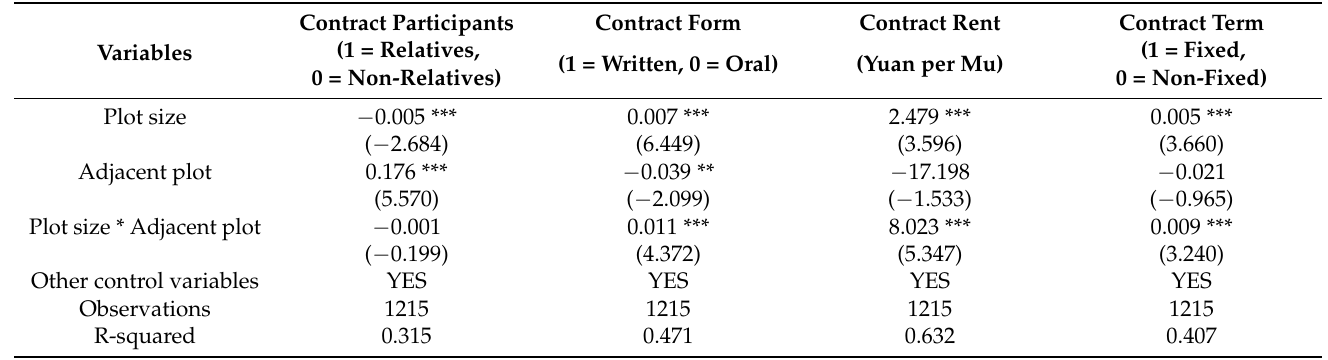
Table 6. The impact of the characteristics of rented-in plots on contract choice, SUR estimation with cross term.